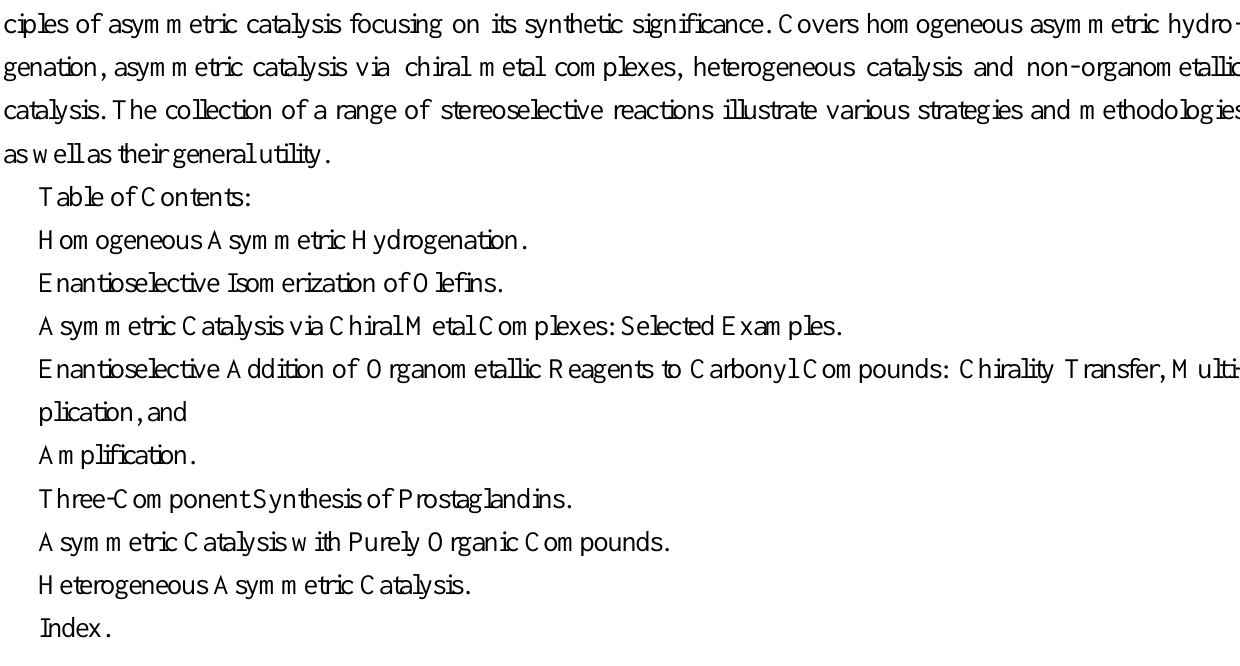
Table of Contents: Homogeneous Asymmetric Hydrogenation. Enantioselective Isomerization of Olefins. Asymmetric Catalysis via Chiral Metal Complexes: Selected Examples. Enantioselective Addition of Organometallic Reagents to Carbonyl Compounds: Chirality Transfer, Multi- plication,